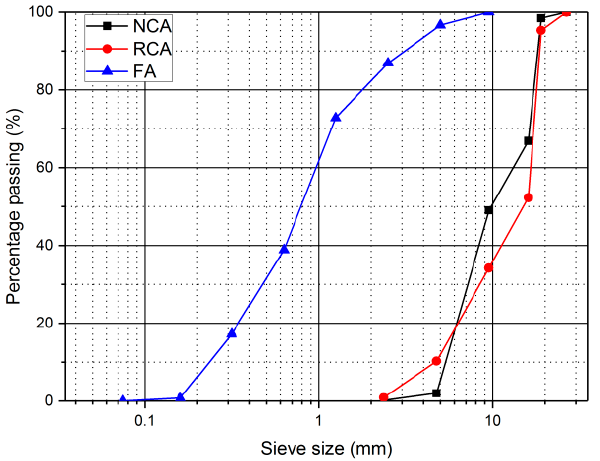
Figure 1. Grading distribution of natural coarse aggregate (NCA), recycled coarse aggregate (RCA) and fine aggregate FA.